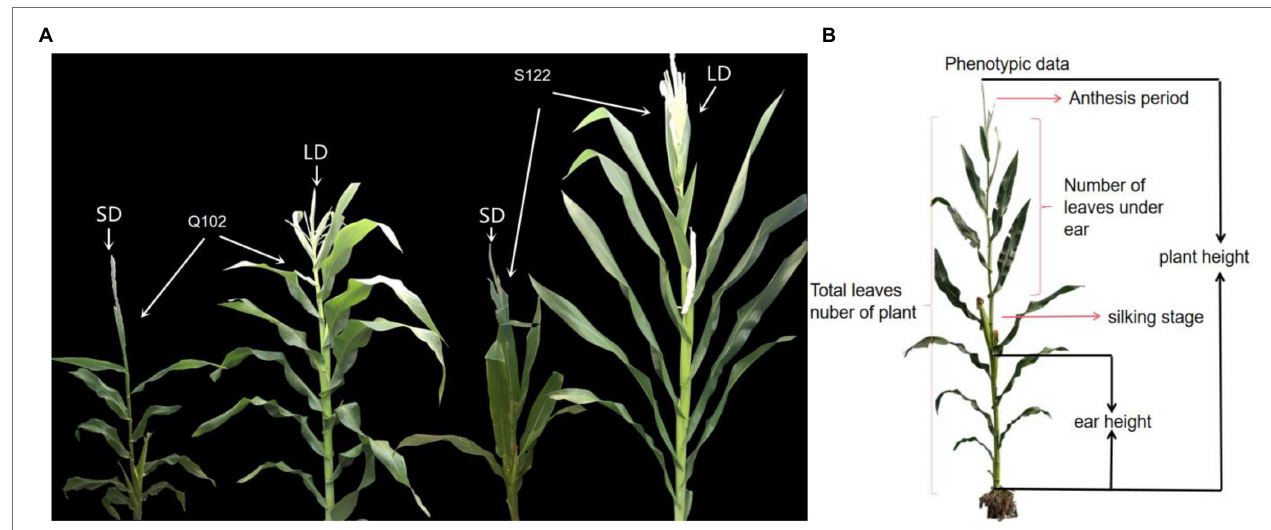
FIGURE 1 | Photoperiod-sensitive phenotypes in maize plants. (A) Phenotypes of RIL population parents under LD (15/9 h, light/dark) (Fei et al., 2022) and SD (9/15 h, light/dark) conditions. (B) Schematic diagram of the measurement positions of photoperiod-sensitive